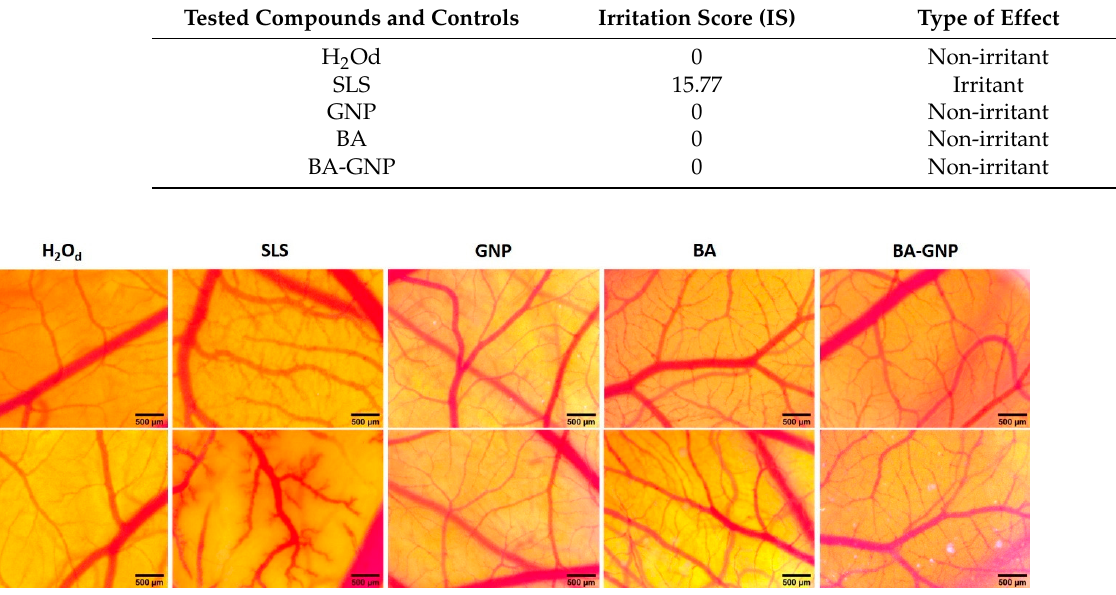
Figure 11. Irriitation potential assessment using the HET-CAM method. Stereomicroscope images show the in-face chorioallantoic membrane before (T 0 ) and 300 s after application (T 5 ) of 300 μ L of the test sample in concentrations of 1 μ M and control samples (distilled water H2O as negative control, SLS 0.5% as positive control and DMSO 0.5% as solvent control); scale bars represent 500 μ m.